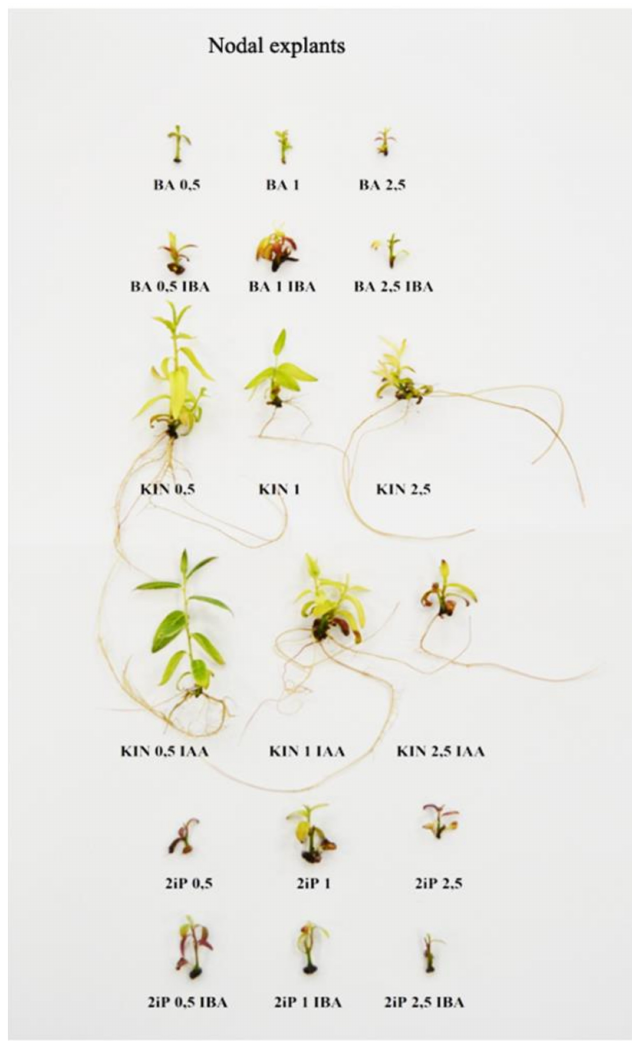
Figure 2. The representative plants obtained from S. lapponum shoot nodal explants during in vitro cultivation on the media supplemented with di ff erent growth